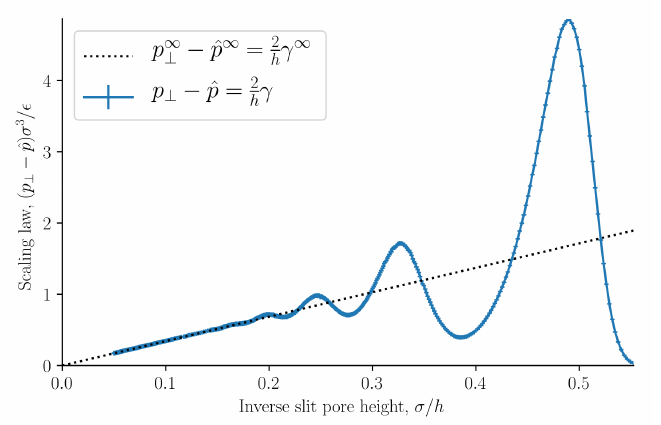
Figure 10. The scaling of normal pressure minus integral pressure as a function of the inverse slit pore height h